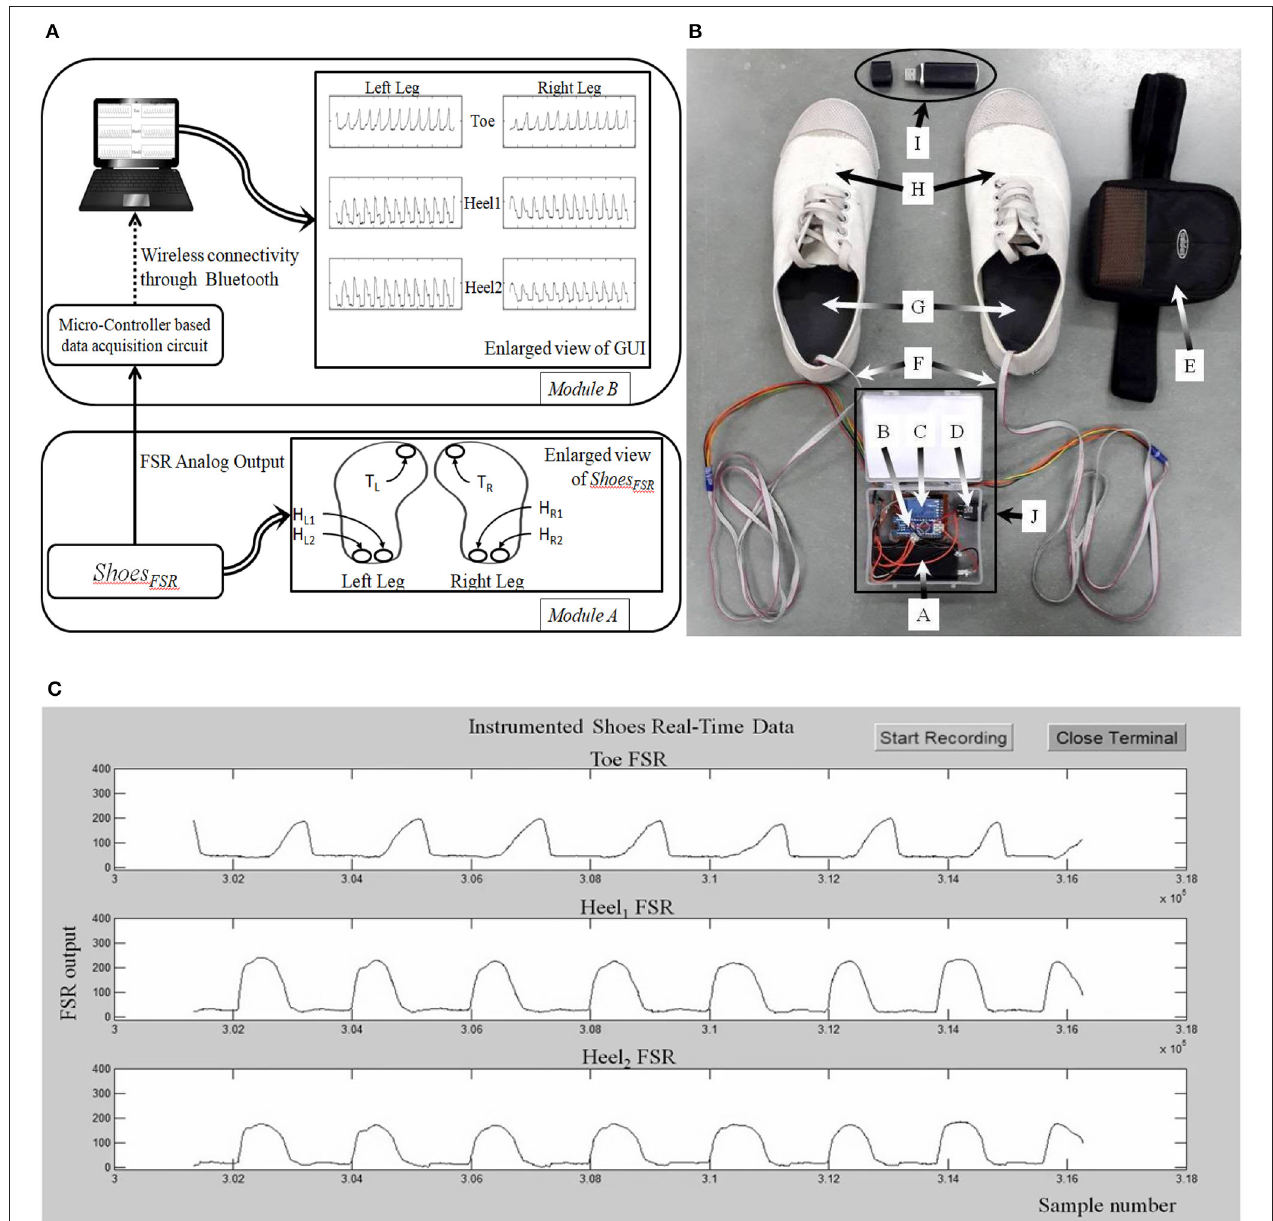
FIGURE 1 | (A) Block Diagram of Shoes FSR ; (B) Photo of Shoes FSR (Physical appearance) with Data Acquisition Module (DAQ); (C) A snapshot of graphical user interface. T L /T R : FSR GD placed below Left and Right toe respectively; H L1 /H R1 : 1st FSR GD placed below Left and Right heel; H L2 /H R2 : 2nd FSR GD placed below Left and Right heel; A: Battery for DAQ; B: Micro-controller circuit for DAQ; C: Bluetooth Transmitter; D: ON/OFF switch for DAQ; E: Case to mount DAQ at the subject’s pelvis; F: Wires connecting DAQ and FSR GD mounted in shoe-insole; G: Shoe-insole mounted with FSRs; H: Shoes FSR ; I: Bluetooth Receiver; J: Data Acquisition Module.